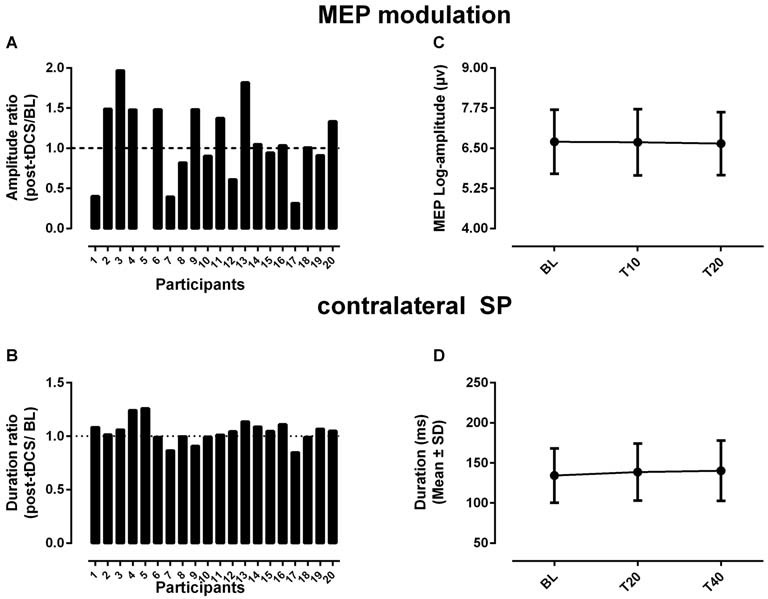
Changes in MEP amplitude (A,C) and in the contralateral silent period (SP) duration (B,D) in response to a-tDCS. In (A,C) changes are shown for each individual as a ratio of the grand average computed for all time points post-tDCS divided by baseline (i.e., post-tDCS/BL). The dotted lines in each graph indicate no change relative to baseline. Note that the missing data (A) refers to an outlier (participants #5) whose MEP data had to be removed from the analysis. In (B,D) the overall changes are shown as means and standard deviations computed across all participants and for each time point before (BL) and after a-tDCS. Note the relatively large variability observed between individuals for modulation in MEP amplitude (A) and in cSP duration (C).